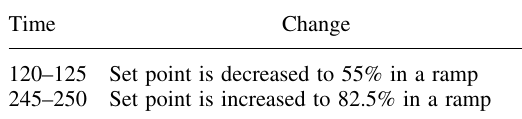
Table 4. Simulation details for set point changes